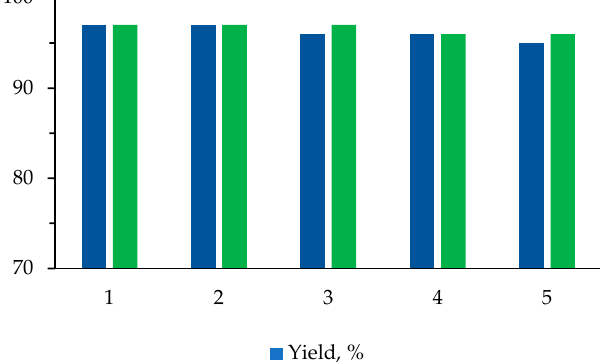
Figure 4. Studies.